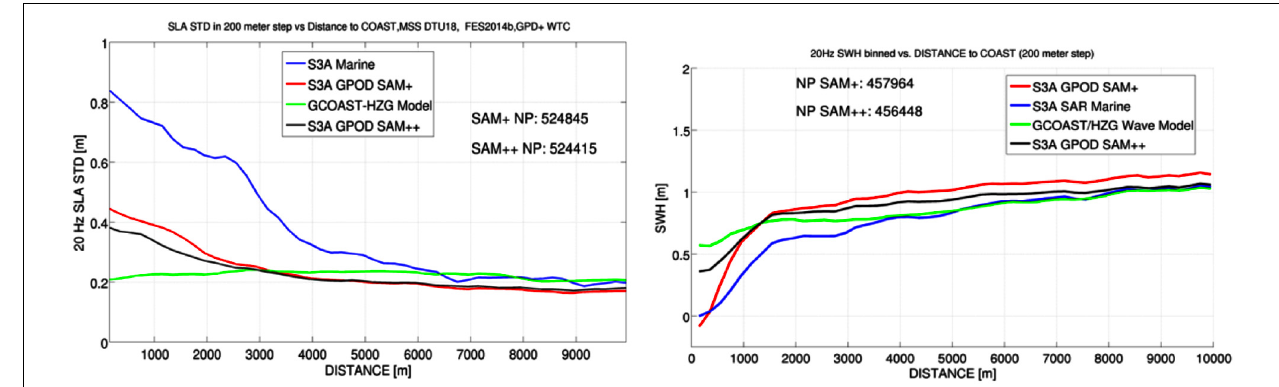
FIGURE 3 | Sea level anomaly (SLA) standard deviation (STD) in 200 m bins (left) and 20 Hz median significant wave height – SWH – (right) as a function of distance to the coast, for retrackers SAMOSA++ (black curve), SAMOSA+ (red curve), together with SAR Marine (blue curve), and numerically simulated data (GCOAST model – green curve). NP stands for number of points (adjusted from Dinardo et al.,